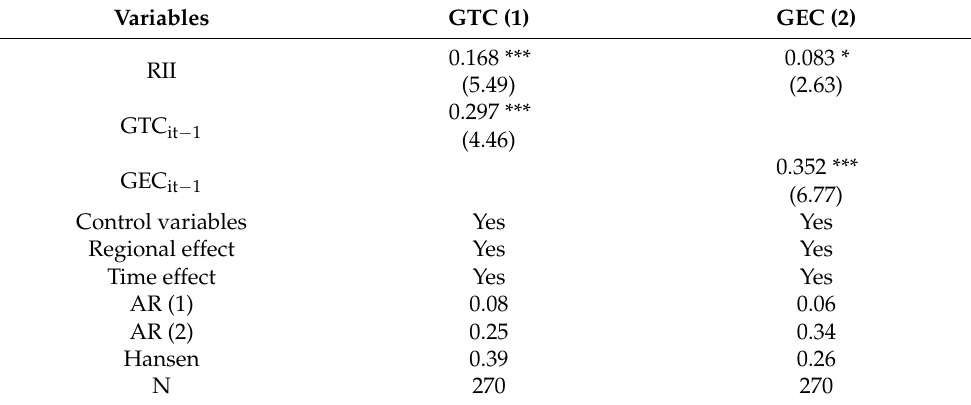
Table 6. Heterogeneity test based on each segmentation index of agricultural